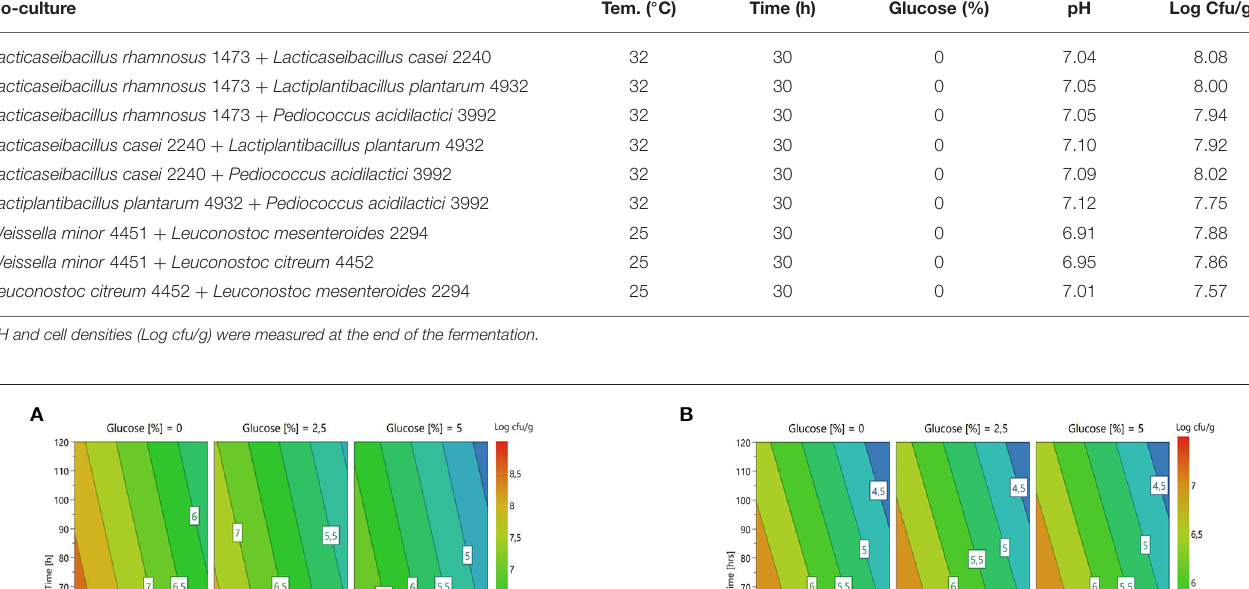
2-methoxy-4-methyl phenol is higher in the sample fermented by the co-cultures (.06-.07 µ g/g) with respect to the others (0.02– 0.04 µ g/g). The concentration of benzaldehyde remains constant in almost all conditions except for NS samples fermented with L. rhamnosus 1473 in condition n.2 and for the co-cultures. In this study, we observed an increase of hexanol after fermentation with L. plantarum and co-culture in NS vanilla beans, while in S